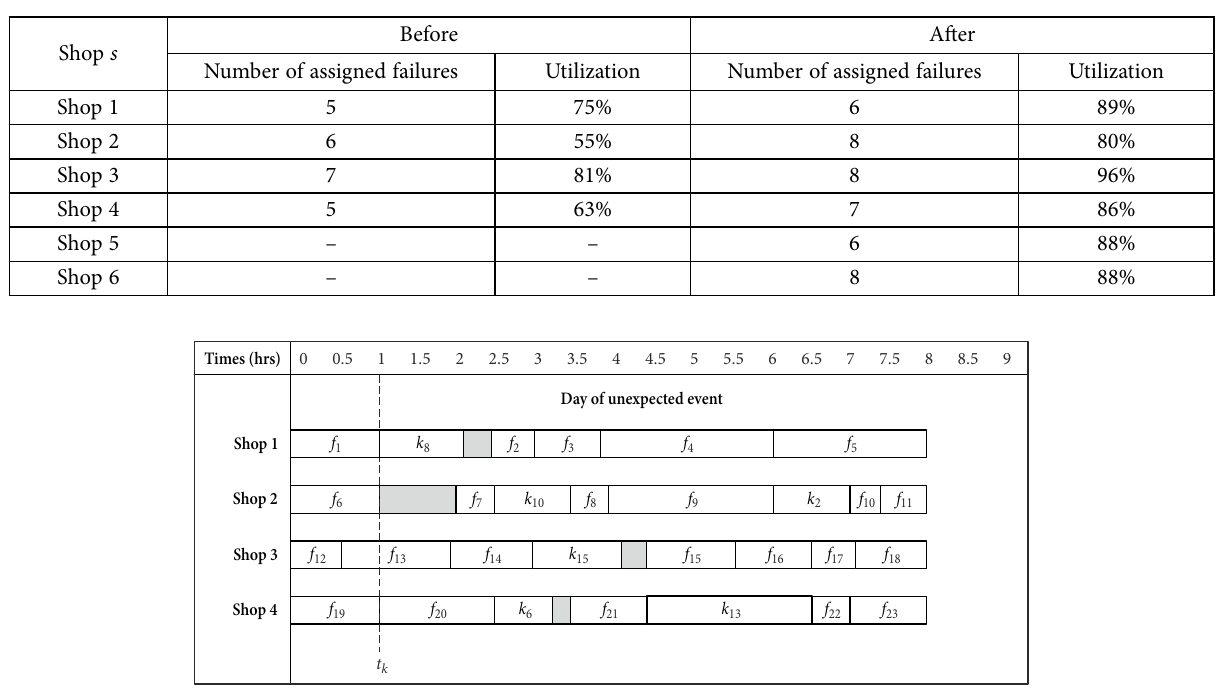
Table 12. Number of assigned failures and utilization of the shops